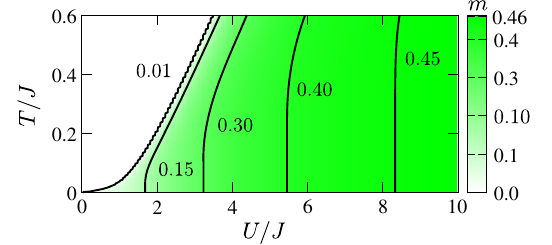
FIG. 2. Diagram showing the ð U; T Þ dependence of the staggered magnetization, m , obtained by solving Eq. (29) in a 40 × 40 lattice.